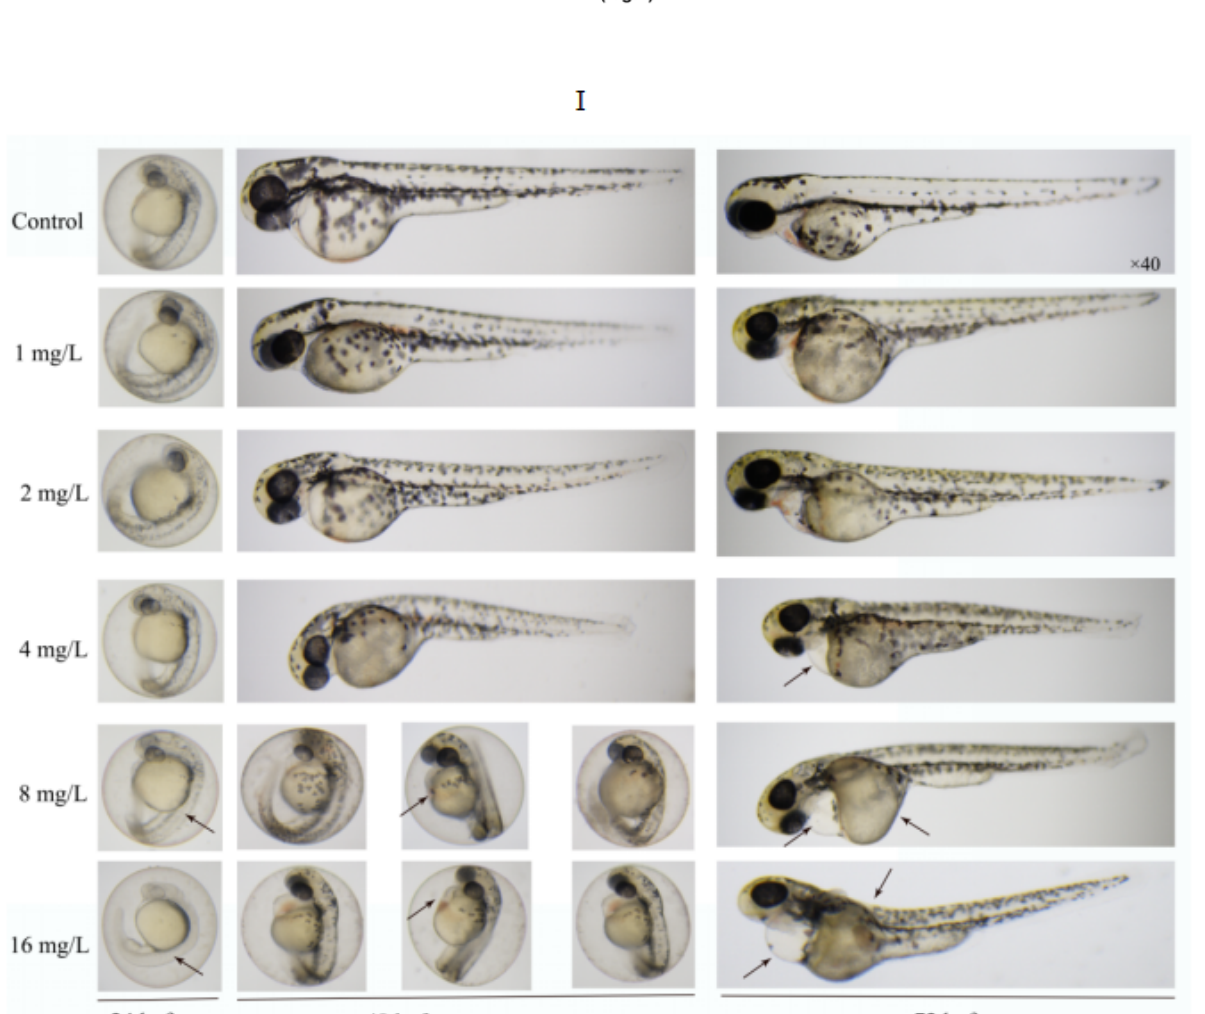
Figure 4. The effects of compound 6b and 6c exposure to zebrafish embryos. Note: ( A ) Zebrafish embryos autokinetic movement per minute after exposure to compound 6b from 6 to 24 hpf; ( B ) The hatchability of zebrafish embryos exposed to 6b from 24 to 96 hpf; ( C ) The developmental abnormalities of zebrafish embryos exposed to 6b at 96 hpf; ( D ) The mortality of zebrafish embryos exposed to 6b at 96 hpf; ( E ) The main phenotypic changes of zebrafish embryos and larvae under 6b exposure from 24 to 96 hpf; ( F ) The hatching rate of zebrafish embryos exposed to 6c at 72 hpf; ( G ) The malformation rate of zebrafish embryos and larvae under 6c exposure at 96 hpf; ( H ) The mortality of zebrafish embryos exposed to 6c at 96 hpf; ( I ) The main phenotypic changes of zebrafish embryos and larvae under 6c exposure from 24 to 72 hpf. “*” represents significant differences at * p ≤ 0.05, ** p ≤ 0.01 and *** p ≤ 0.001 by one-way ANOVA followed by a Dunnet test.